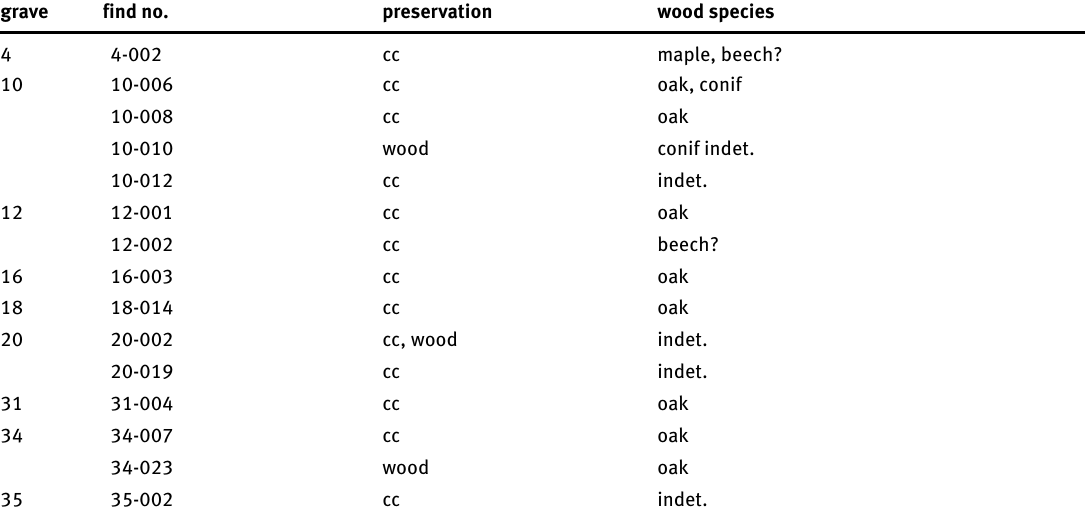
Table 3: Wood species analysis of coffins (hw – hardwoods, conif - conifers, cc – charcoal, wood – not carbonized,